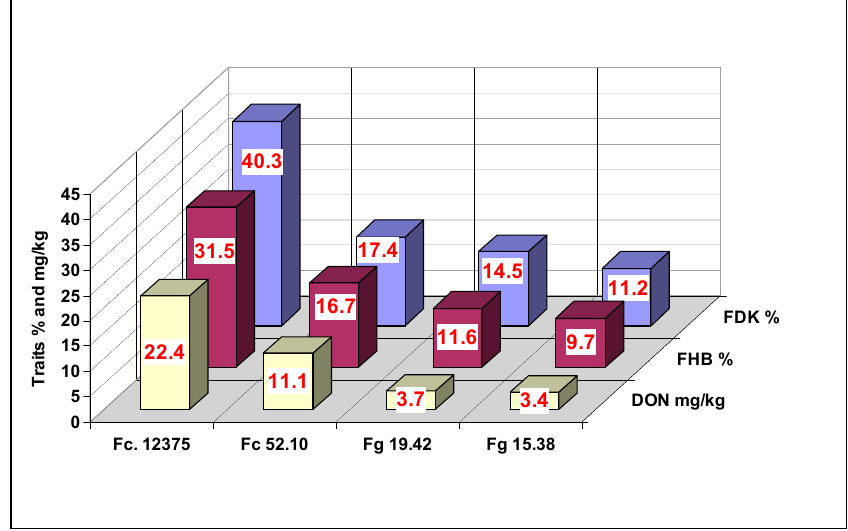
Figure 8. Performance of the isolates tested for the three traits in the inoculum dilution test against FHB in wheat, 2013 and 2014. LSD 5%: DI = 0.72, FDK = 1.53, DON = 0.99.